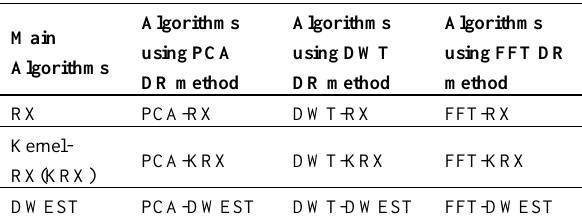
Table 1. Addressing AD